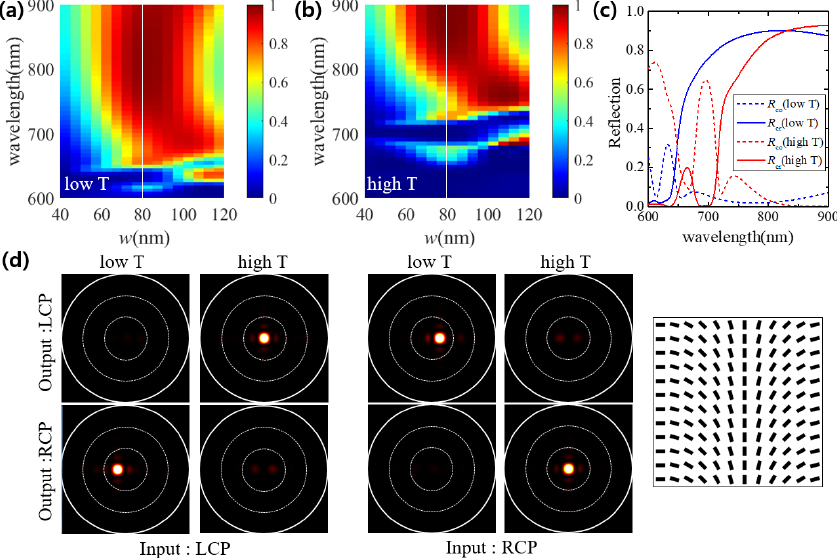
Figure 3. Characteristics of metasurface. ( a ) Thickness-dependent reflection spectral map at low temperature and ( b ) at high temperature. ( c ) Reflection spectra of the co-polarized and cross-polarized light at low temperature and high temperature marked with white lines in ( a , b ). ( d ) Manipulation of beam steering with different input polarization at λ = 700 nm. Inset in the right is the in-plane cut view of Au nanorods in the